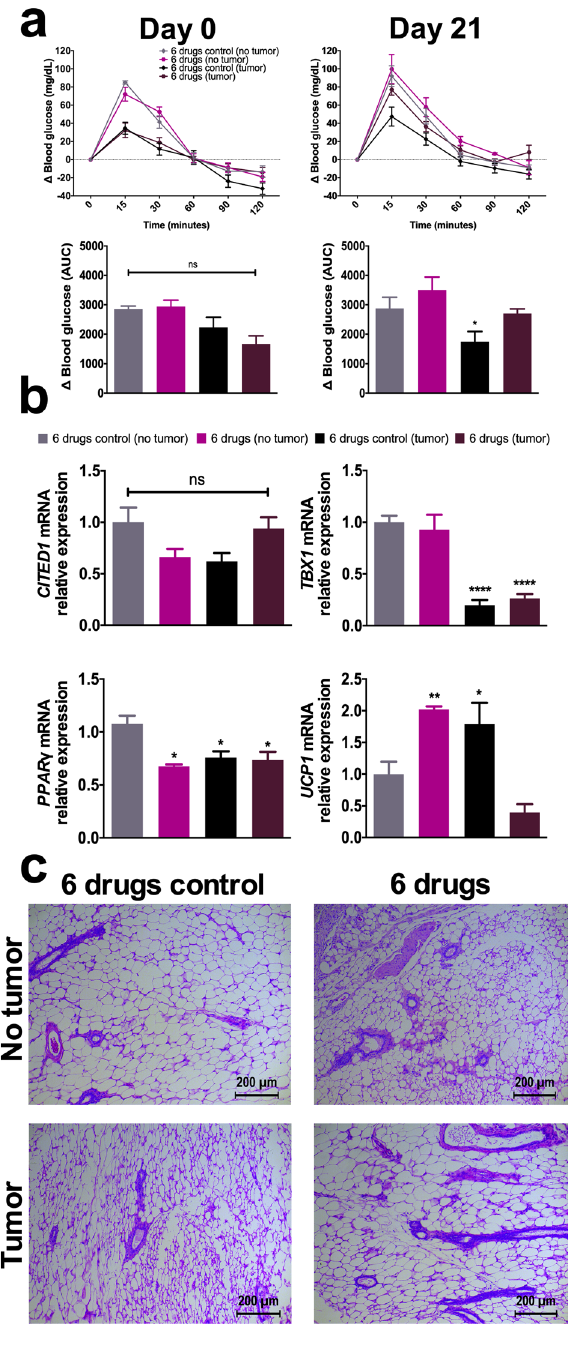
Figure 6. The 6 drugs scheme reverts the low glucose peak seen in non-treated, tumor-bearing mice, and prevents the loss of subcutaneous fat mass. ( a ) Delta of blood glucose at days 0 and 21 of treatment, and the area under the curve per condition. ( b ) mRNA relative expression of CITED1 , TBX1 , PPARγ , and UCP1 . ( c ) H&E staining of subcutaneous fat samples isolated after 21 days of treatment. H&E Images are presented at 10X magnification. The images are representative of the data obtained. Data are expressed as means ± s.e.m. N = 1 independent experiment, 10 mice/group. Statistical analyses were performed with one- way ANOVA with Dunnet correction. Scale bars = 200 μm. 6 drugs: Orlistat + lonidamine + DON + growth hormone + insulin + indomethacin ; AUC: Area under the curve; ns: non-significant; *p < 0.05 ; **p < 0.01 ; ****p <